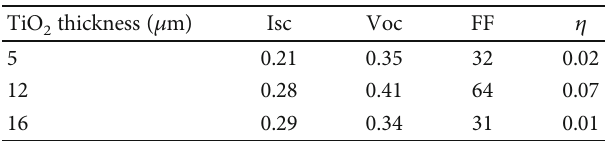
Table 5: Electrical and e ffi ciency parameters of solar cells with fi lms, where Isc is the short di ff erent thicknesses of the TiO 2 circuit current density (mA · cm 2 ), Voc is the open circuit voltage (V), FF is the fi ll factor (%), and η is the conversion e ffi ciency (%). The measurements were carried out under one sun (100mW · cm -2 ) on masked cells (active area 0.19cm 2